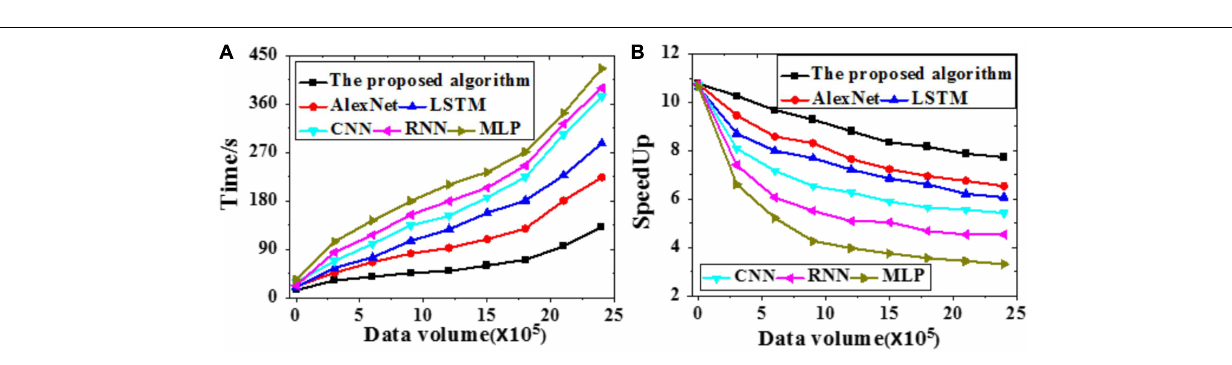
FIGURE 10 | Time required and speedup indicator of different models under different data volumes (A) Time required; (B) Speedup